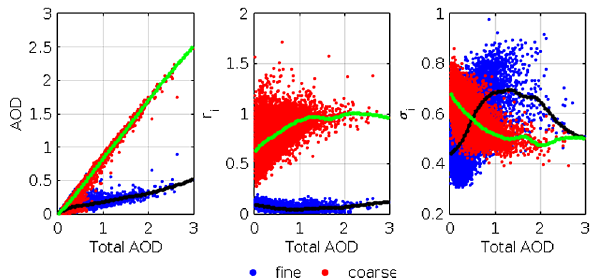
Figure 10. Fine- and course-mode AOD (blue and red, respectively, left panel) at 674nm, modal radius r i (middle panel) and standard deviation σ i (right panel) derived from Aeronet Inversion Level 2.0 product over the Arabian Peninsula. Thick lines indicate fitted val- ues of the fine (black) and coarse (green) mode used in sensitivity calculations.